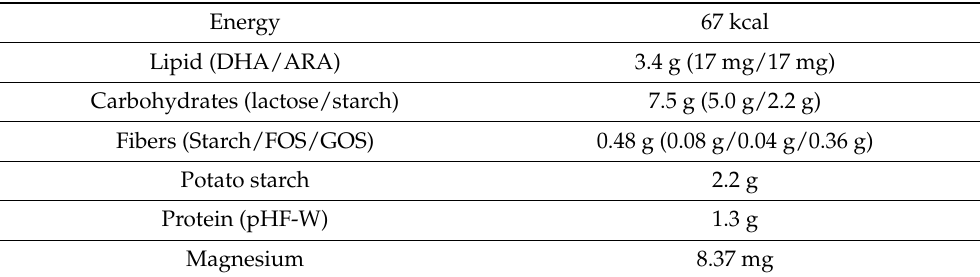
Table 1. Composition of study formula per 100 mL.